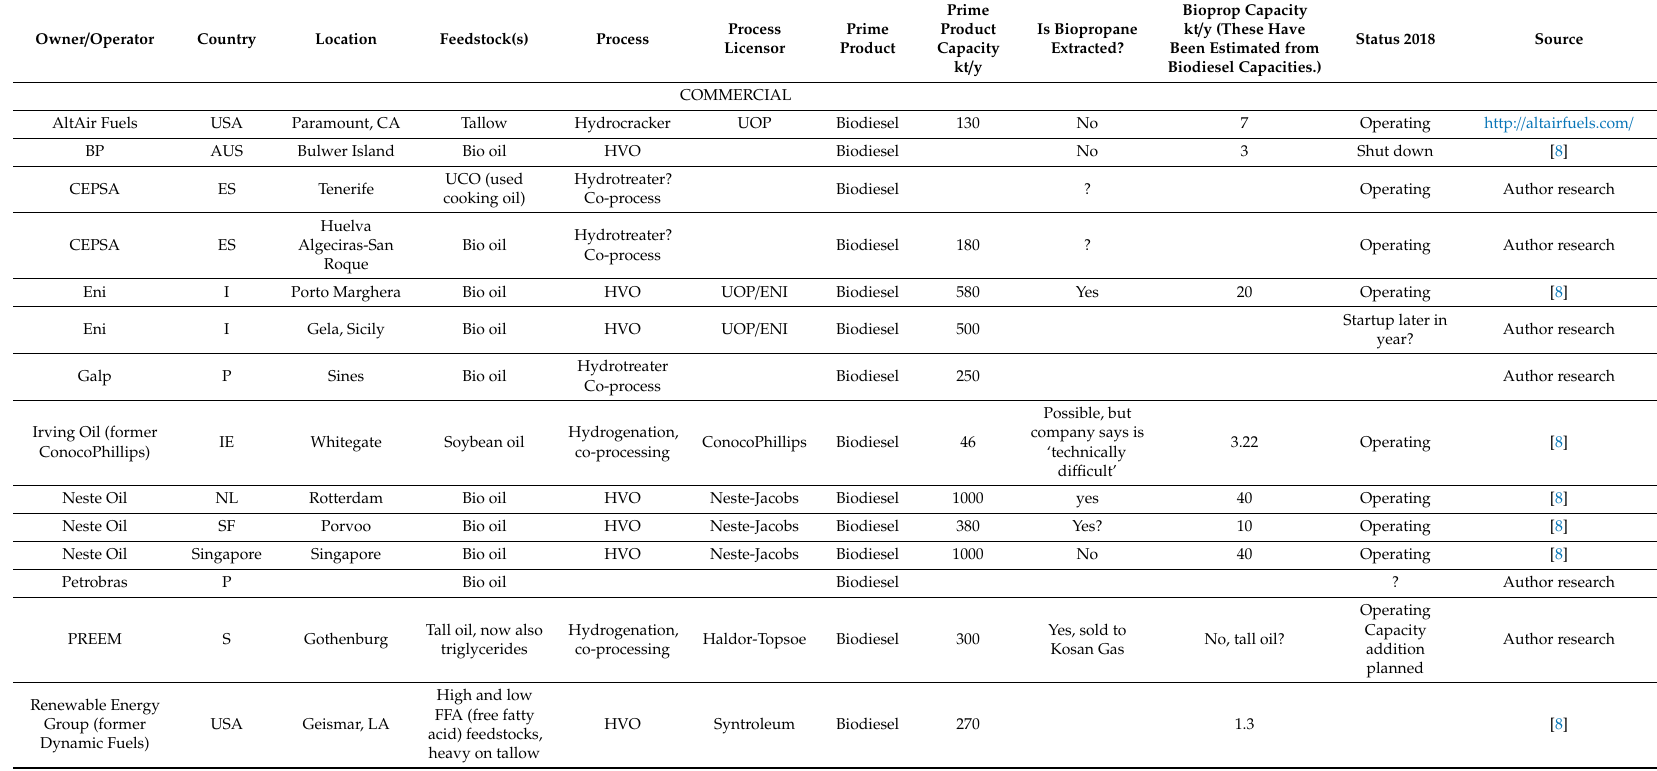
Table 2. Hydrotreatment projects for BioLPG, by technological readiness.